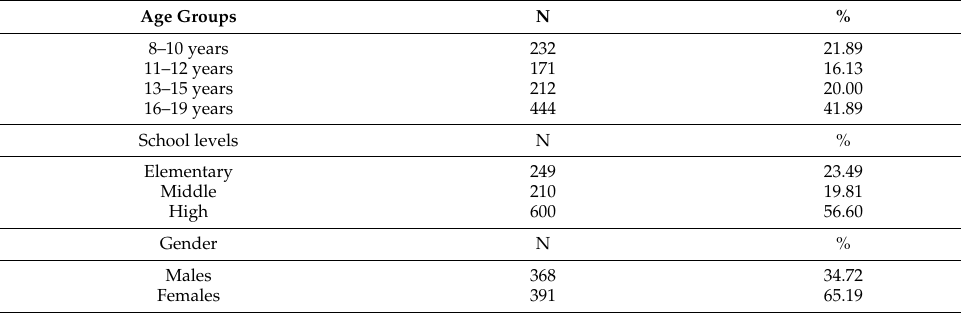
Table 1. Demographic characteristics of the